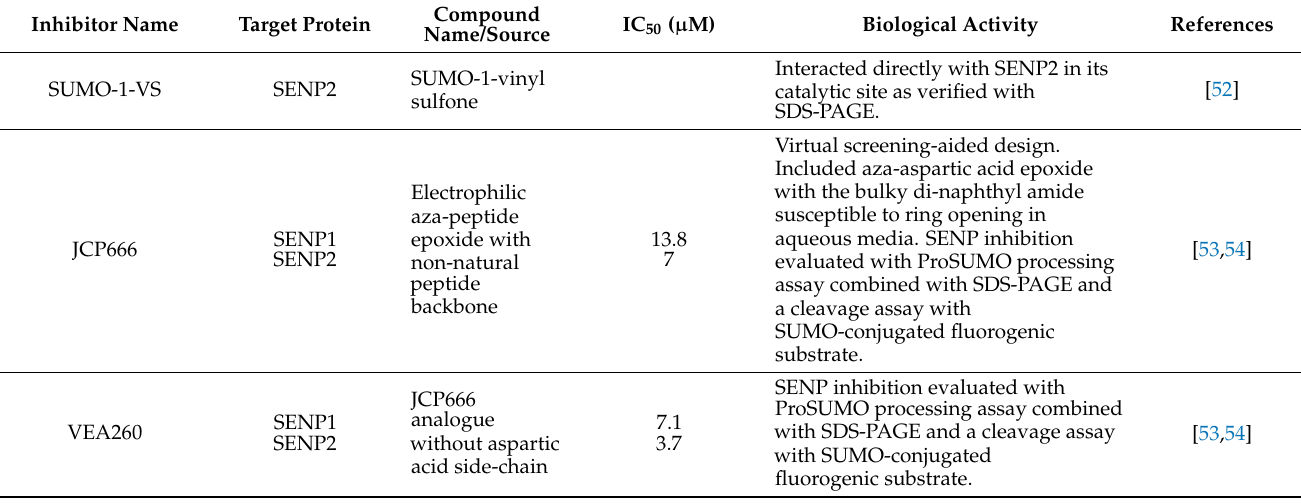
Table 2. SENP Proteases